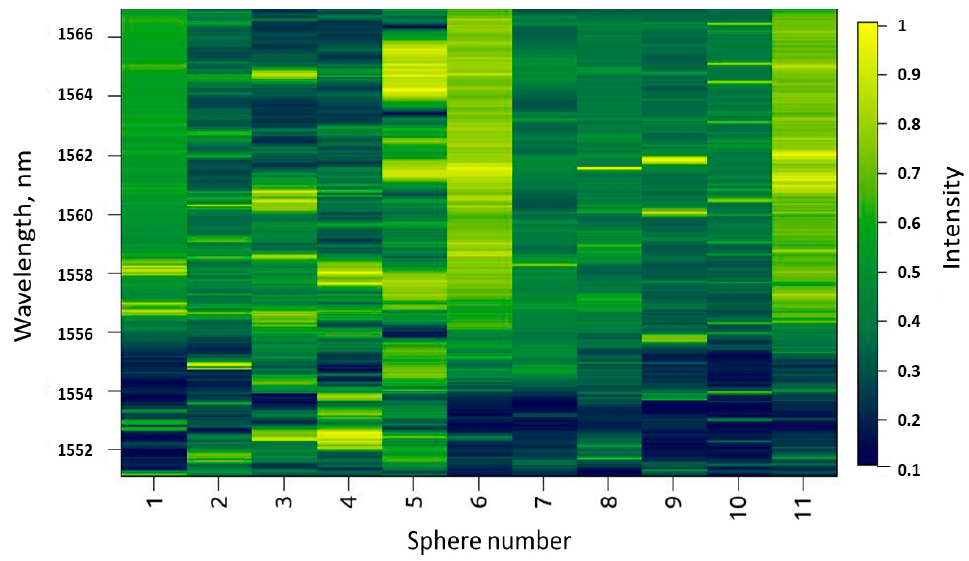
Figure 4. Average intensity is shown in the barcode system for 11 different PMMA microspheres attached to the tapered fiber. This mode map can be used for unknown wavelength determination.